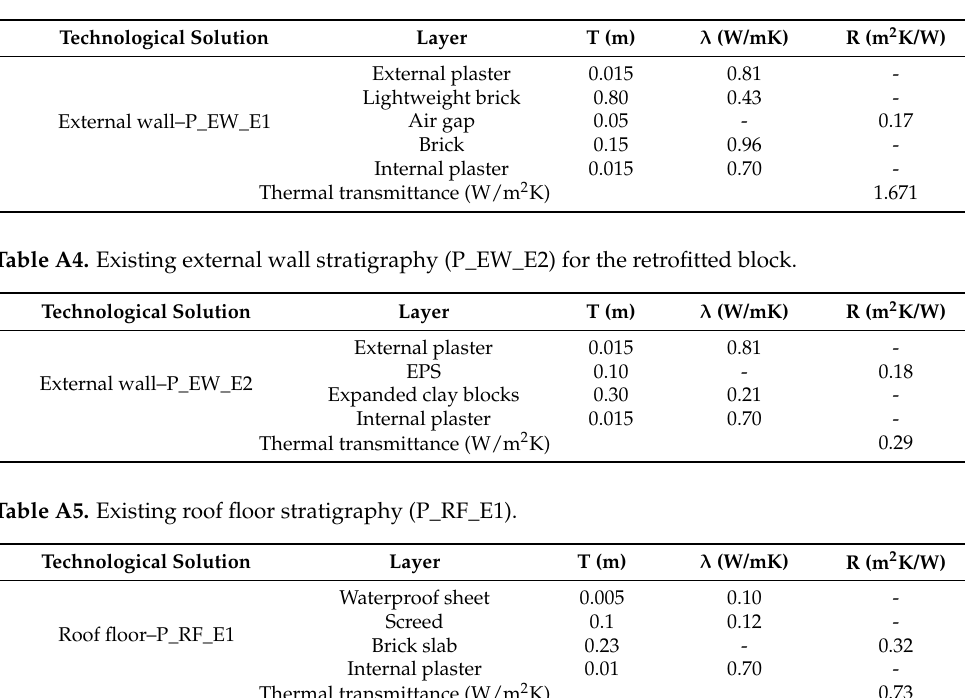
Table A3. Existing external wall stratigraphy (P_EW_E1).